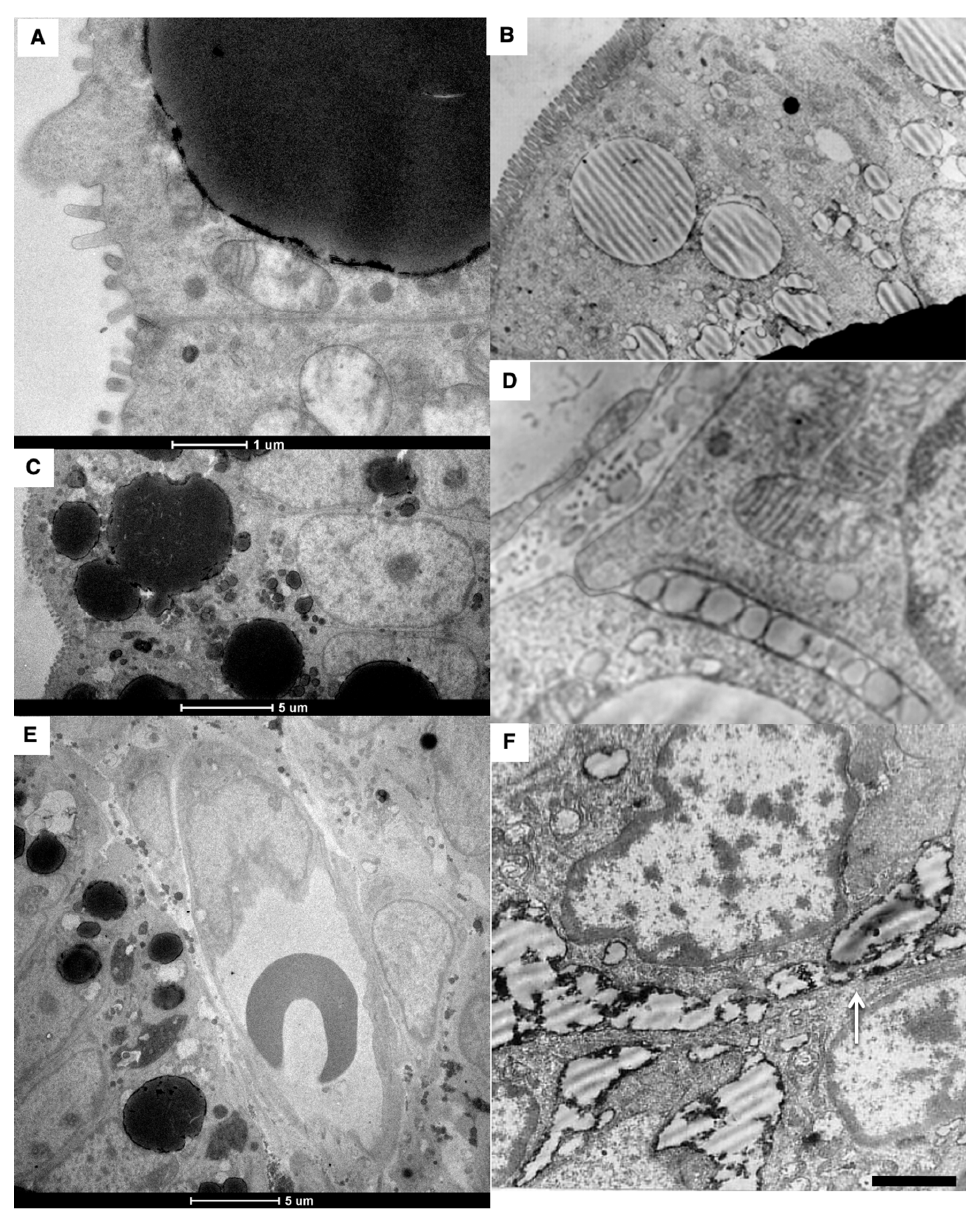
Figure 6. Structure of small intestine enterocytes in newborn rats after their first feeding. ( A – C ) Formation of huge droplets and “lipid lakes” in enterocytes of newborn rats after the first feeding. ( A , C ) Thick (200 nm) sections. ( D ) Large ChMs between enterocytes. ( E ) The lumen of the blood capillary with the erythrocytes inside its lumen does not contain chylomicrons. ( F ) “Lipid lakes” between enterocytes. Scale bars: 1050 nm ( B ); 290 nm ( D ); 610 nm ( F ). In ( A , C , E ), scale bars are indicated below each image.